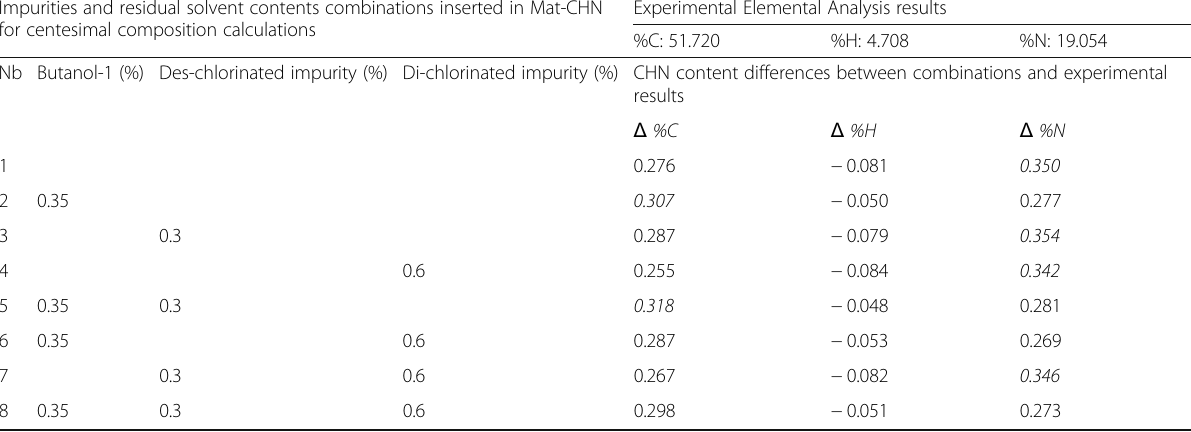
Table 5 Contributions of the different combinations of residual solvent and impurities contents on the experimental Elemental Analysis